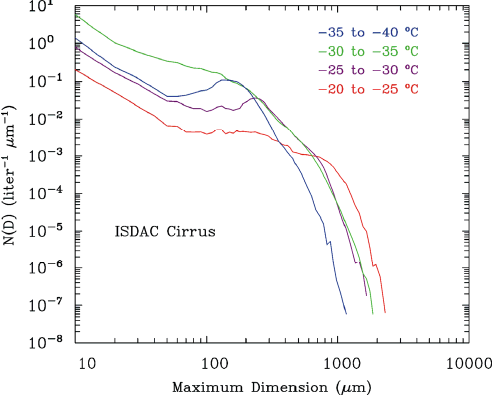
Figure 1. Temperature dependence of Arctic cirrus PSD sampled during the ISDAC field campaign. Fig. 1. Temperature dependence of Arctic cirrus PSD sampled dur- ing the ISDAC field campaign.